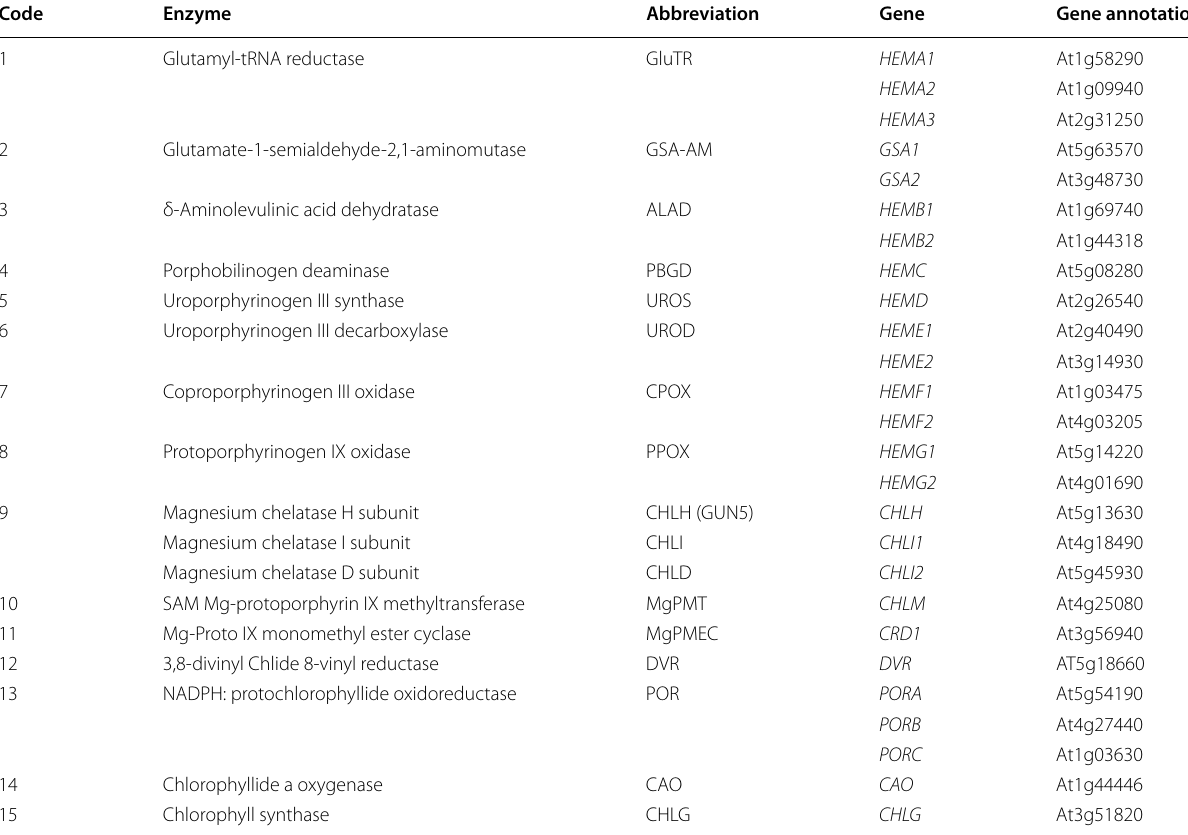
Table 1 Genes and enzymes involved in chlorophyll biosynthesis in plant